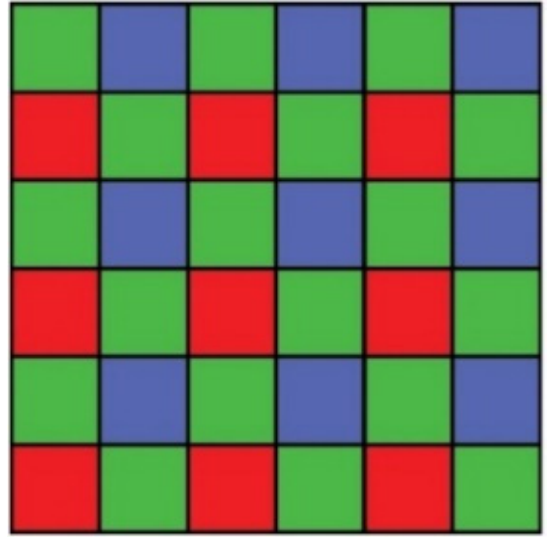
Figure 4. Bayer color filter array (CFA) pattern, as widely used in color CMOS sensors [38]. Demosaicing methods can be grouped into two groups. The first group of algorithms works on each color channel separately. They include nearest-neighbor replication, bilinear interpolation, and cubic spline interpolation. The second group of algorithms exploits inter- channel correlation. One approach in this group is smooth hue transition, which assumes that the hue does not change abruptly between neighboring pixel locations. In the first step, these algorithms interpolate the luminance (green) channel, which is usually achieved using bilinear interpolation. The chrominance channels (red and blue) are estimated from the bilinearly interpolated “red hue” (red-to-green ratio) and “blue hue” (blue-to-green ratio). Another approach that exploits inter-channel correlation is an edge-directed interpolation. Here, the bilinear interpolation of the green channel is replaced by adaptive interpolation to prevent interpolation across edges